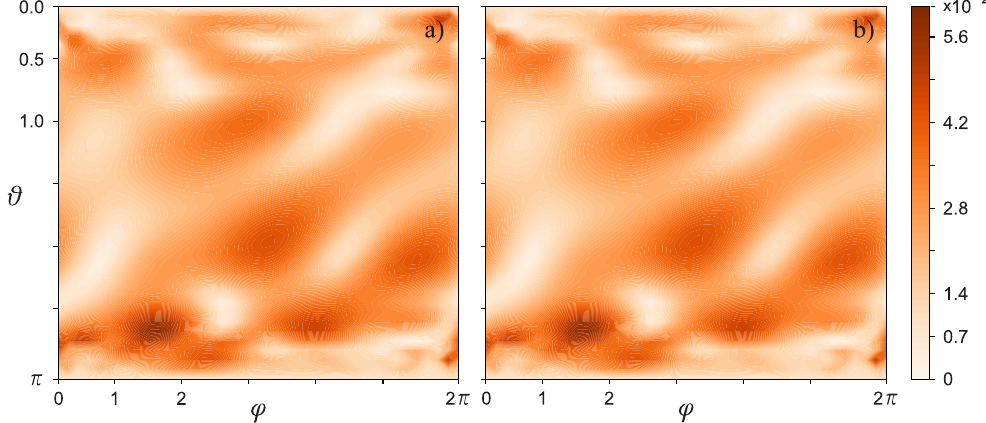
Figure 4. The normalized value of the magnitude of the retrieved magnetic mass carrier density M ( ρ cos ϕ sin θ , ρ sin ϕ sin θ , ρ cos θ ) . The calculations were carried out for data localized in the spher- ical layer S 2 . Regularization parameter: ( a ) α = 10 − 12 , ( b ) α = 10 − 14